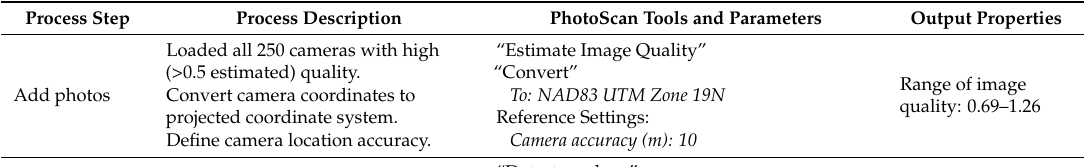
Table A1. Parameters used during SfM processing to create the dense point